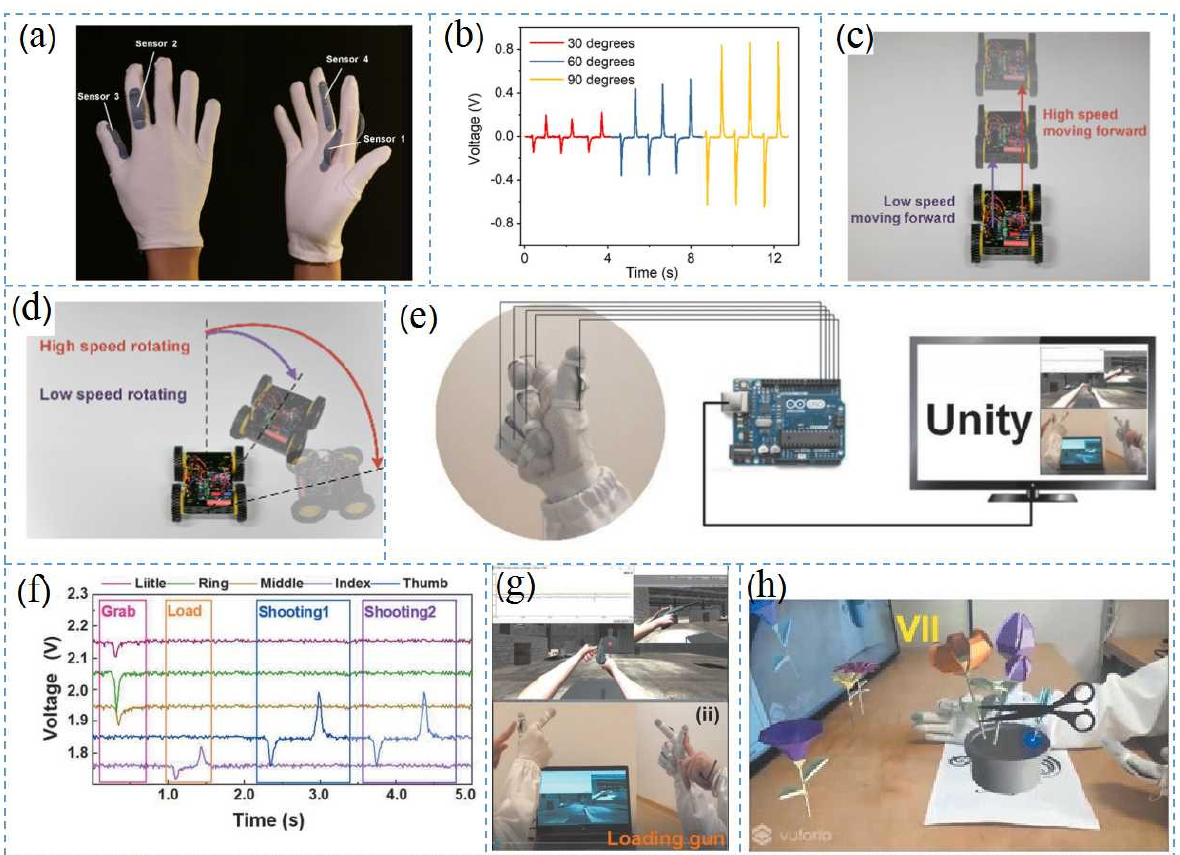
Figure 7. Applications of TENG-based VR gloves: ( a ) self-powered gloves using a PEDOT:PSS coating process; ( b ) voltage output of the sensor when the index finger was bent at different angles; ( c ) and ( d ) different driving states of wireless vehicles controlled by gloves. Reprinted with permission from ref.[38]. Copyright 2019 Nano Energy; ( e ) schematic diagram of machine learning glove-controlled gunplay based on self-powered conductive superhydrophobic triboelectric textiles; ( f ) signal modes for fetching, loading, and firing; ( g ) screenshot of gun loading action in Unity VR space; and ( h ) virtual illustration of glove control. Reprinted with permission from ref.